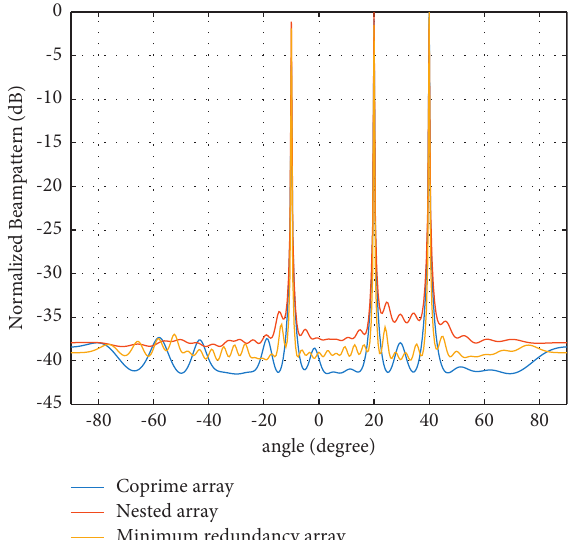
Figure 1: DOA estimation results of three sparse